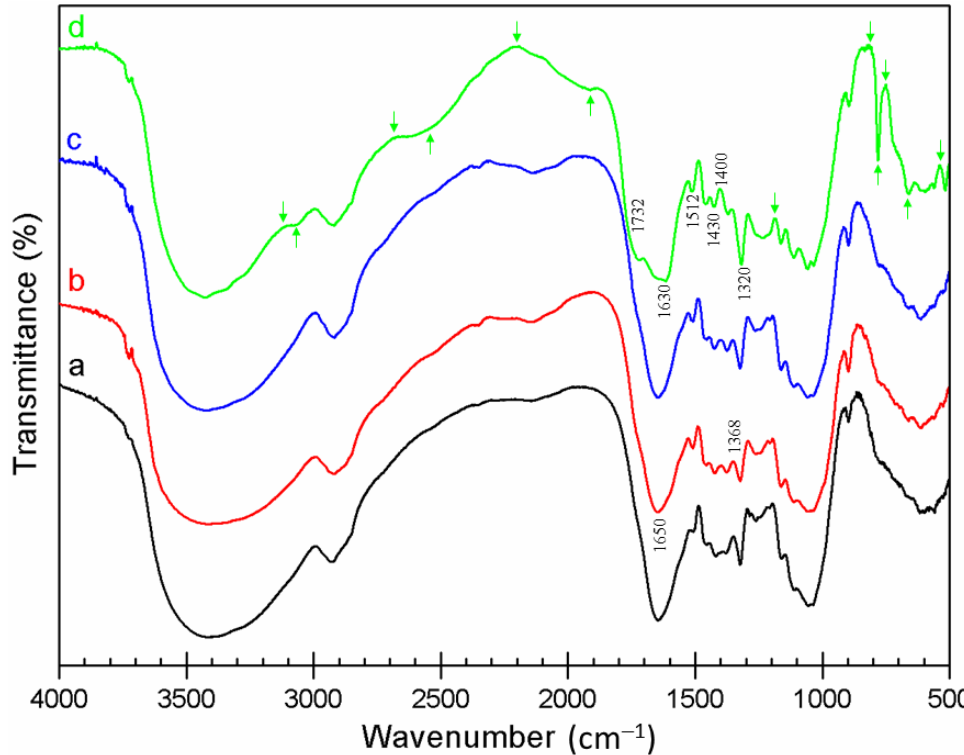
Figure 5. FTIR spectra of (a) raw and pretreated (b) AH, (c) TH, and (d) TCH solid residues of SMS. Arrows show peak variations with respect to the other samples.